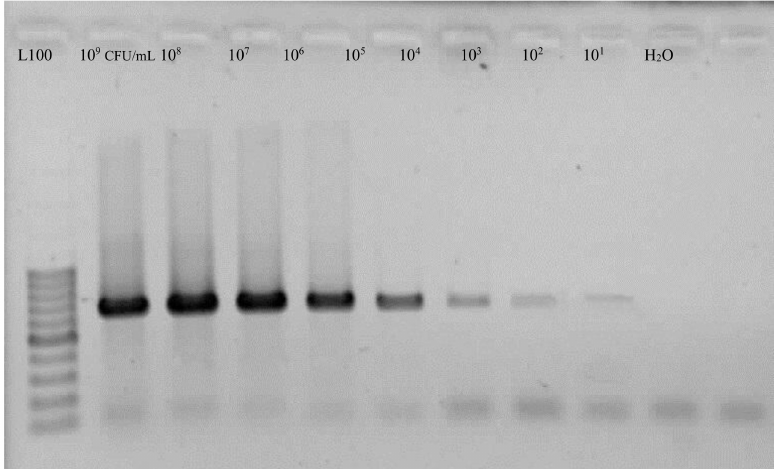
Figure 3. Agarose gel electrophoresis of polymerase chain reaction (PCR) sensitivity on bacterial isolates by Y45 / Y46